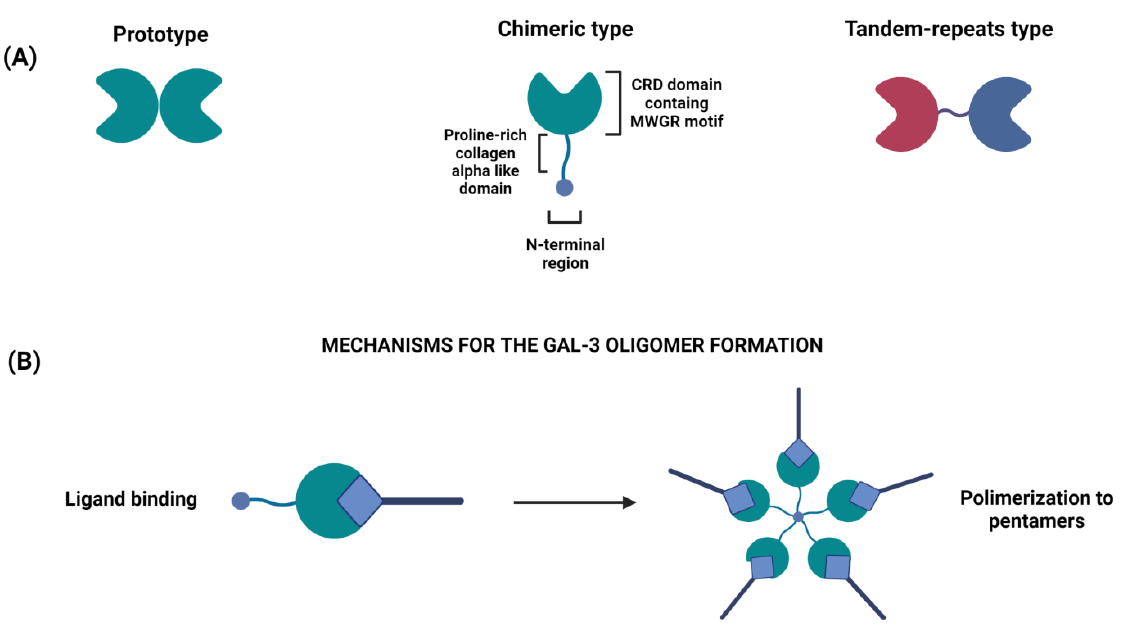
Figure 1. ( A ) Classification of the different types of galectins: prototype (Gal-1, -2, -5,-7,- 20,-11, -13, -14, -15 and -16), chimeric type (Gal-3), tandem-repeat type (Gal-4, -6,-8,-9 and -12). Prototype galectins have one CRD that can dimerize; tandem-repeat galectins have two different CRDs (red and blue colors are used to distinguish them) linked by a linker domain; chimera-type galectin (Gal-3) has a single C-terminal CRD and a N-terminal oligomerization domain. ( B ) Gal-3 oligomerization: upon oligosaccharide binding by the C-terminal domain, the non-lectin domains of Gal-3 oligomerize, thereby cross-linking ligands of the cell surface.